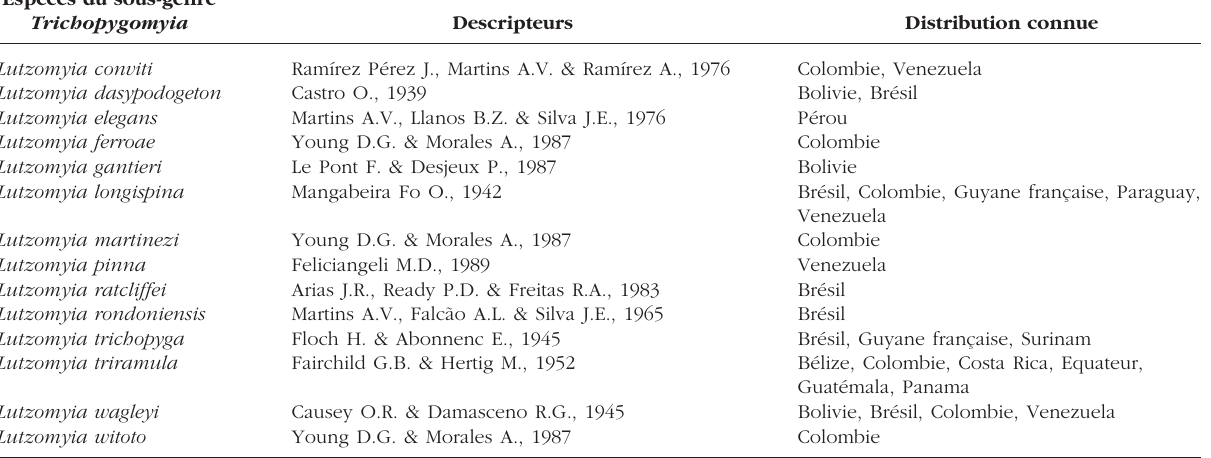
Tableau II. – Distribution connue des espèces du sous-genre Trichomygomyia